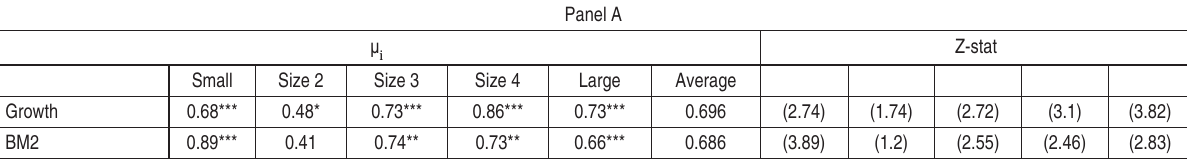
Table 7. The Impact of monetary policy shocks on the ERP of the 25 value-weighted Fama-French